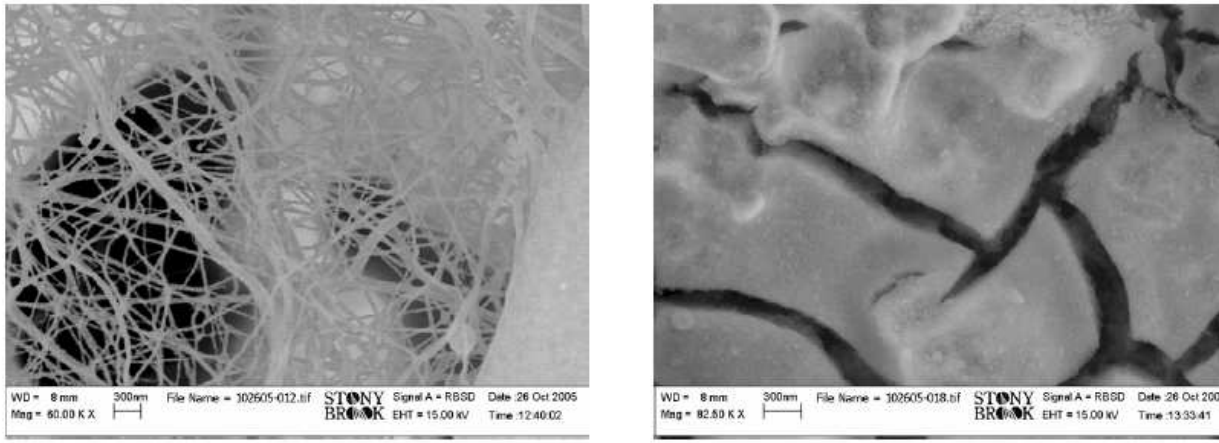
Figure 2. FEG-SEM micrographs of SrTi electrospinning (left) and by electrospraying